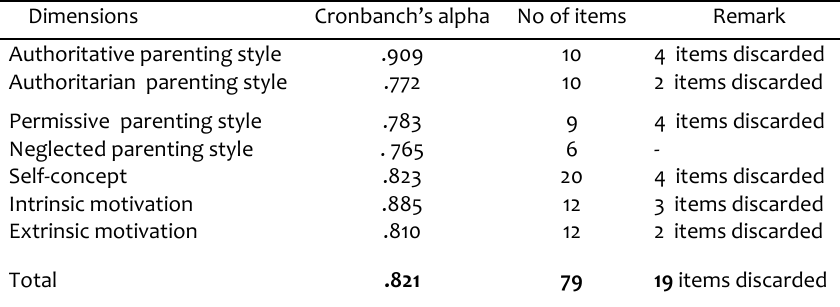
Table 2: Reliability test results with Cronbach's